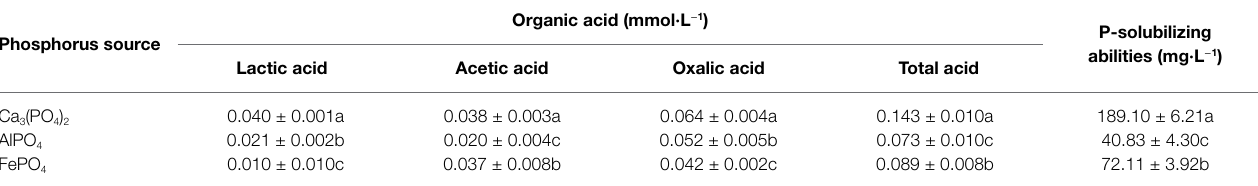
TABLE 2 | The phosphate-solubilizing ability of Penicillium oxalicum F9 in different phosphorus sources.